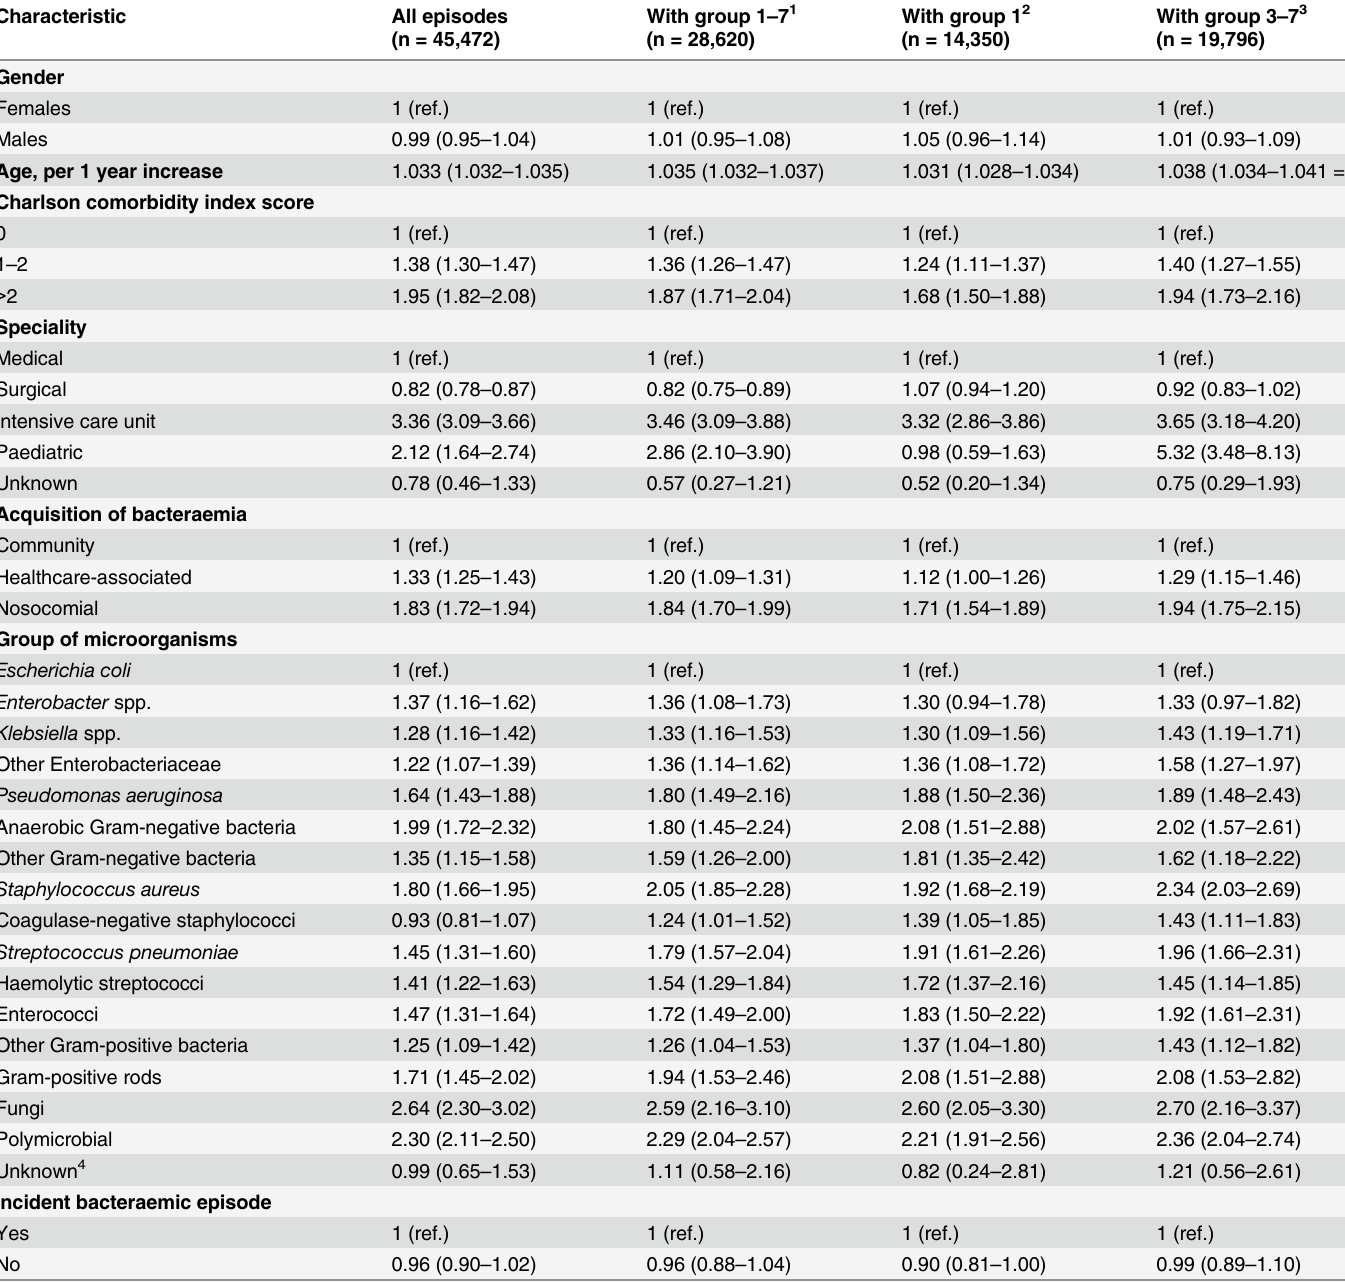
Table 4. Odds ratios (95% confidence intervals) for 30-day mortality, adjusted for characteristics in first column, 2000 – 2008.